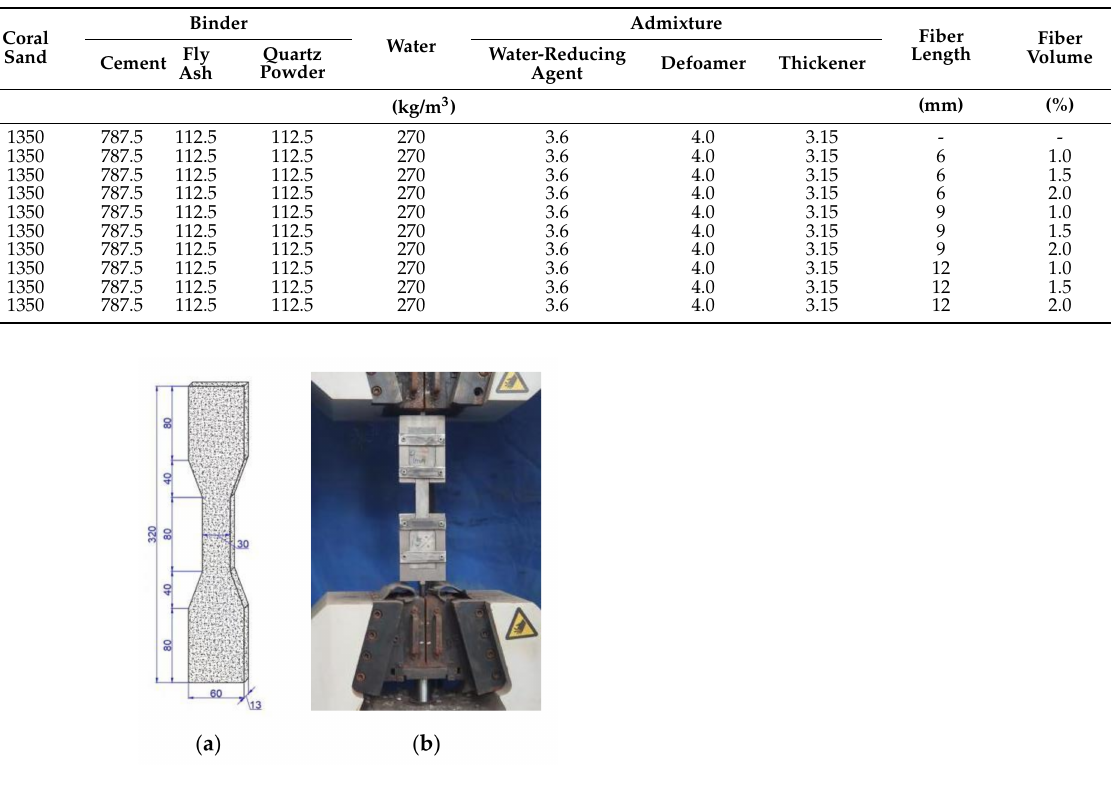
Figure 2. Tensile specimen and tensile loading device. ( a ) Dog-bone specimen (unit: mm); ( b ) Tensile loading device.